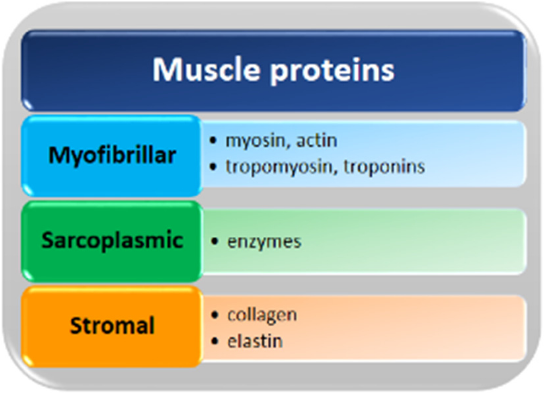
Figure 3. Classification of the principal fish muscle proteins.